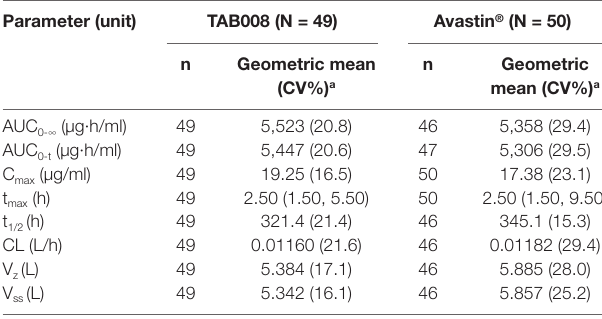
TABLE 1 | Descriptive statistics for geometric mean and geometric CV of pharmacokinetic parameters for each treatment group.